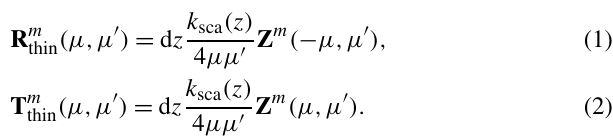
Figure 4. Radiation fields after adding two layers, k and k + 1, into the adding method. Layer k,k + 1 is the combined layer. U k,k + 1 and D k,k + 1 are the upward and downward diffuse internal fields for the combined layer. R k,k + 1 and T k,k + 1 are the reflection and diffuse transmission of the combined layer. E k,k + 1 is the combined direct transmission (direct